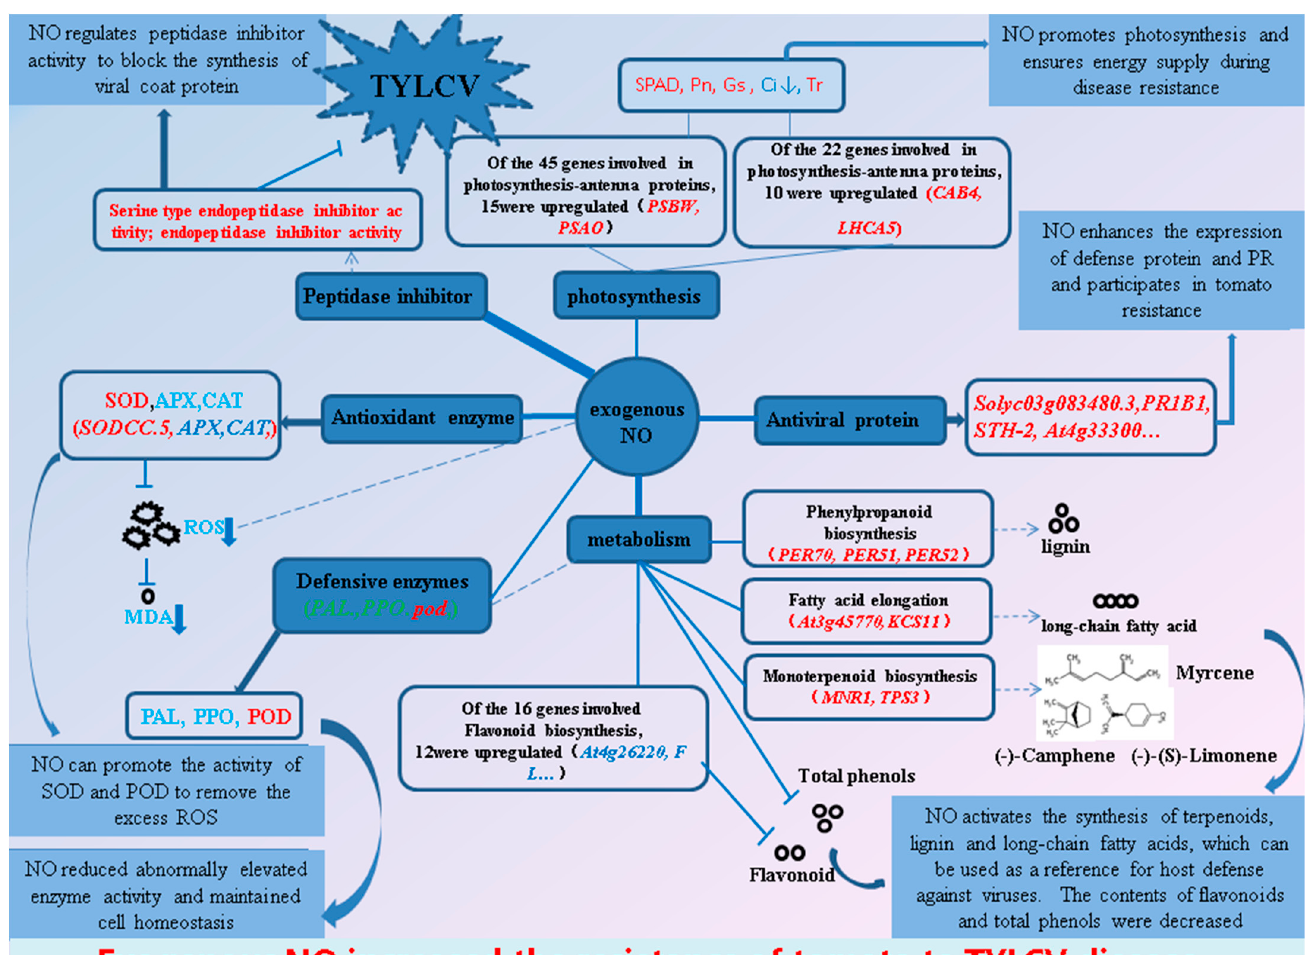
Figure 14. Exogenous NO-mediated resistance of tomato seedlings to TYLCV based on transcrip- tome and physiological changes. Up-regulated and down-regulated genes are represented in red and green, respectively, and up-regulated genes are represented in blue. The thickness of the line connected to the central circle indicates the degree of response of the connected function to the exogenous NO.